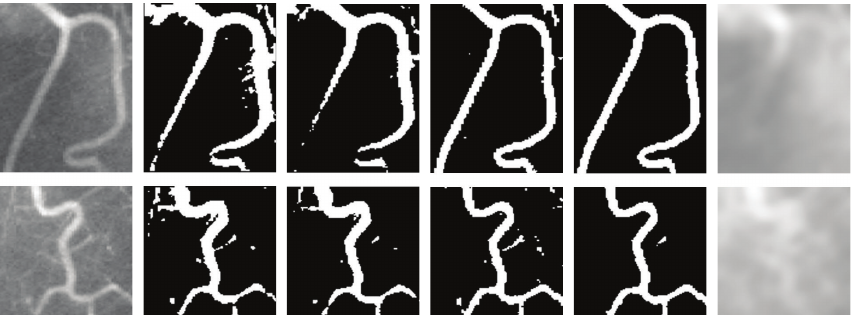
Figure 4: Comparison of segmentation results on two X-ray vessel images. Column 1: original images. Column 2: the BCFCM algorithm. Column 3: the sFCM algorithm. Column 4: the CLIC algorithm. Column 5: the proposed algorithm. Column 6: the estimated bias fields by the proposed algorithm.